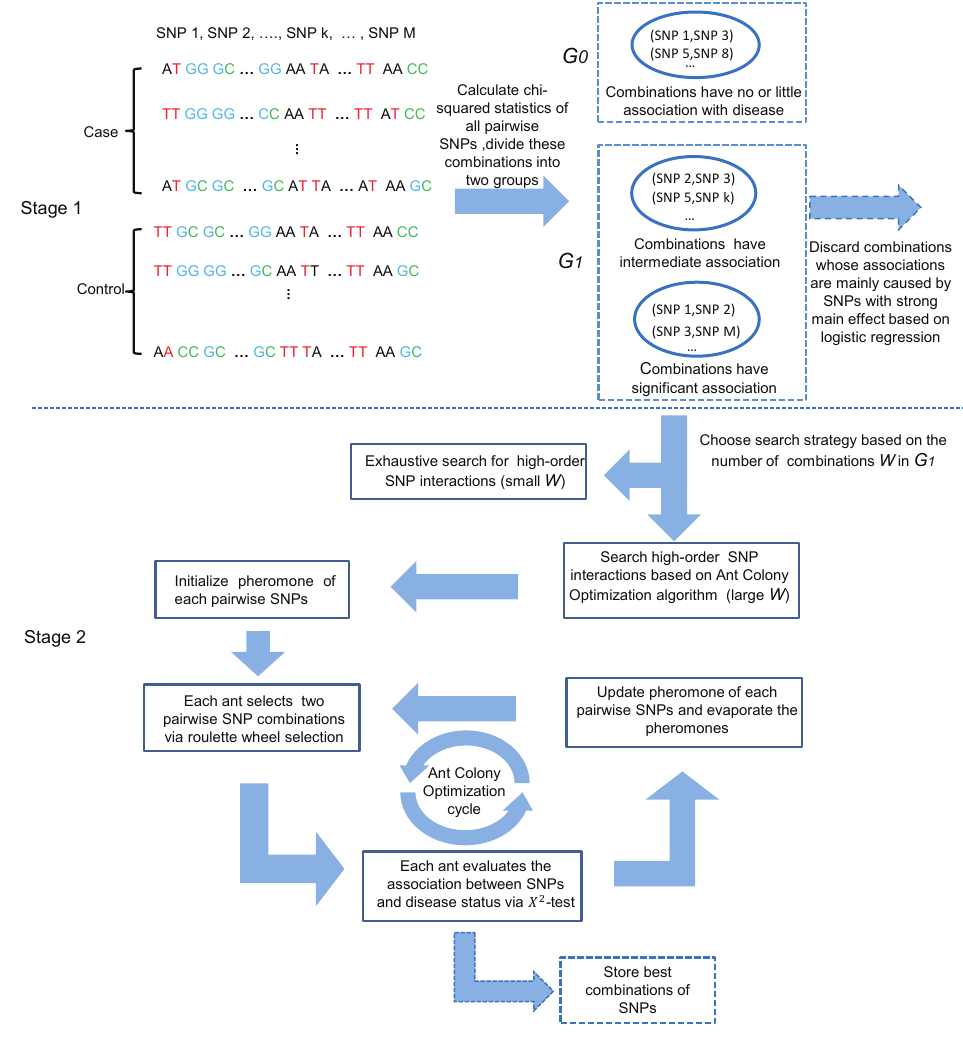
Figure 1. Framework of